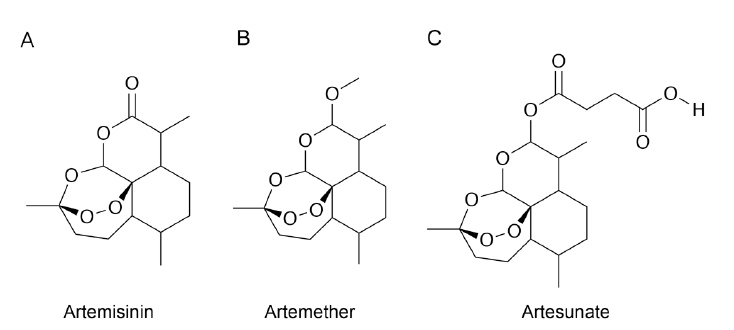
Figure 1. Chemical structures of ( A ) artemisinin, ( B ) Artemether, and ( C )